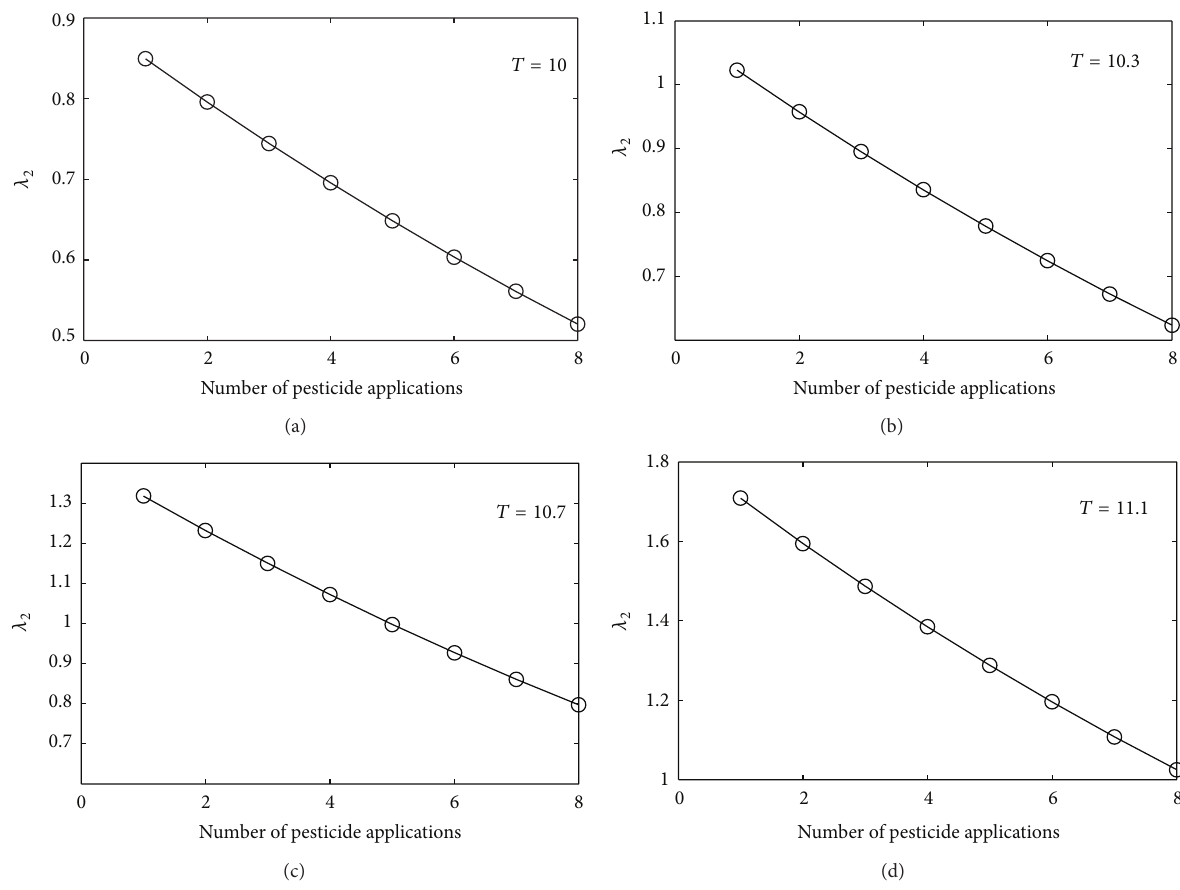
Figure 5: The effects of number of pesticide applications and release period 𝑇 on the threshold level 𝜆 2 with the parameter value 𝛿 3 = 0.93 and other parameters the same as Figure